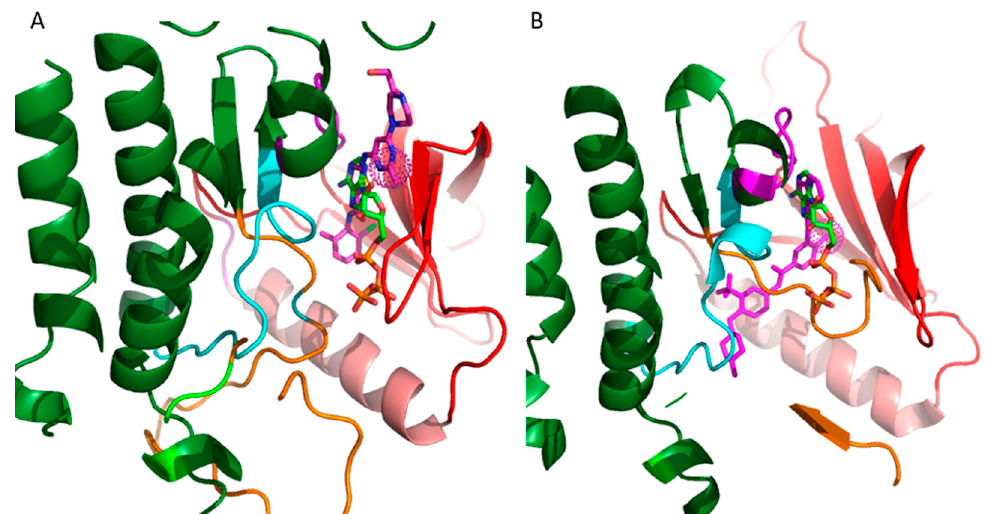
Figure 2 . Binding of type I and type II inhibitors in the ATP pocket or receptor tyrosine kinases (RTKs) alongside ATP for comparison. The inhibitors mimic the interactions that the heterocyclic ring of ATP (green) has with the hinge loop (magenta). ( A ) Dasatanib (magenta), a type I inhibitor, is shown in the binding pocket of Abl2 kinase domain (PDB: 4XLI) locked in active state. The activation loop (orange) is positioned such that it is phosphorylated and is able to recruit substrate proteins. The catalytic loop (cyan) enables the transfer of the phosphate group to the substrate protein; ( B ) Pontatinib, a type II inhibitor, is shown bound to the kinase domain of DDR1 kinase (PDB: 3ZOS) locked in an inactive state. ATP (green) is bound in the active state and is shown here for comparison to Figure 2A. The conformation of the activation loop and the catalytic loop differ from those found in the active state.